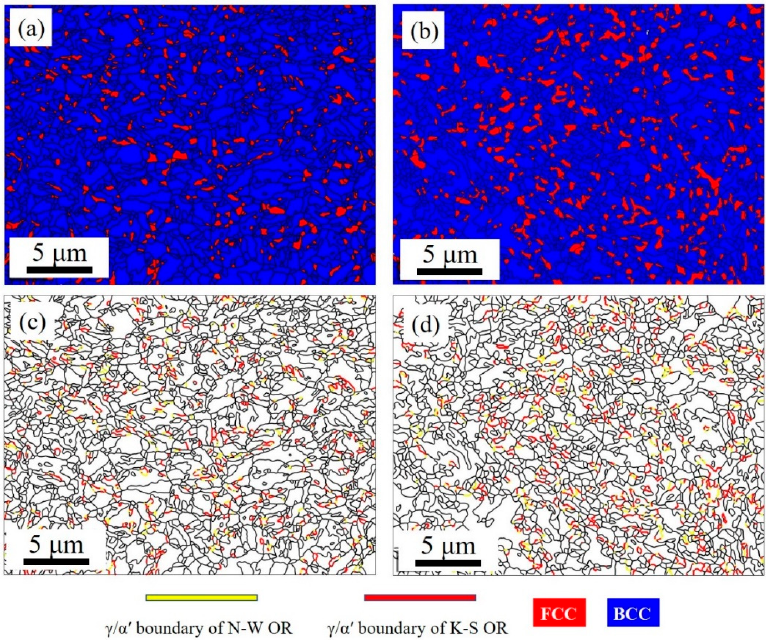
Figure 4. Phase maps of W-Q ( a ) and W-QT&P300 ( b ). The grain boundary maps of W-Q ( c ) and W-QT&P300 ( d ). The phase boundaries of austenite and martensite that exhibit special orientation relationships are highlighted in red, Kurdjumov–Sachs orientation relationships (K − S OR) or yellow, Nishiyama − Wassermann (N − W